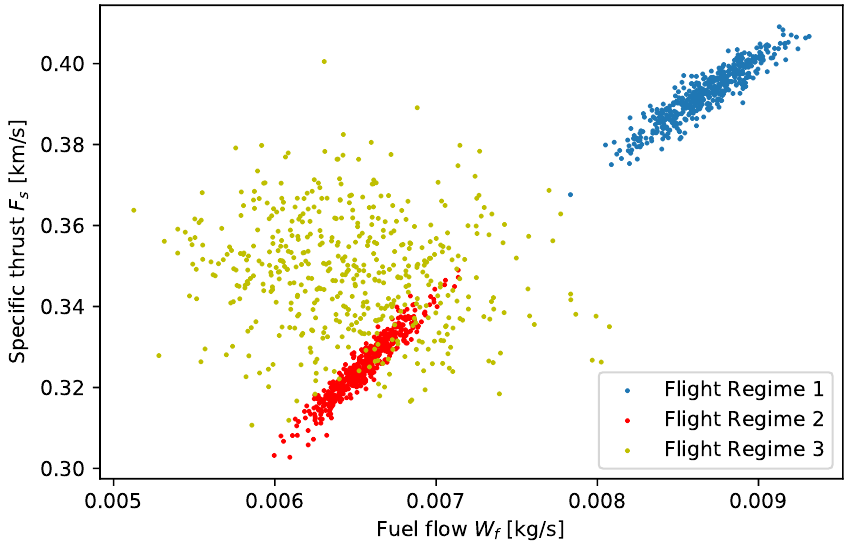
Figure 7. Specific thrust vs. fuel flow for three flight regimes and varying degradation in both